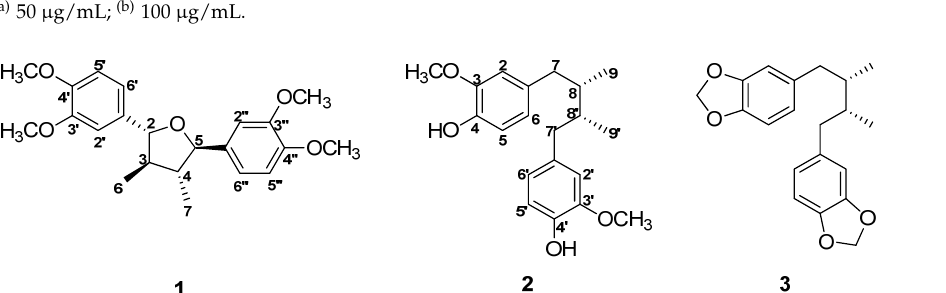
Figure 1. Chemical structures of isolated compounds 1 – 3 of Machilus thunbergii ( M. thunbergii ) .